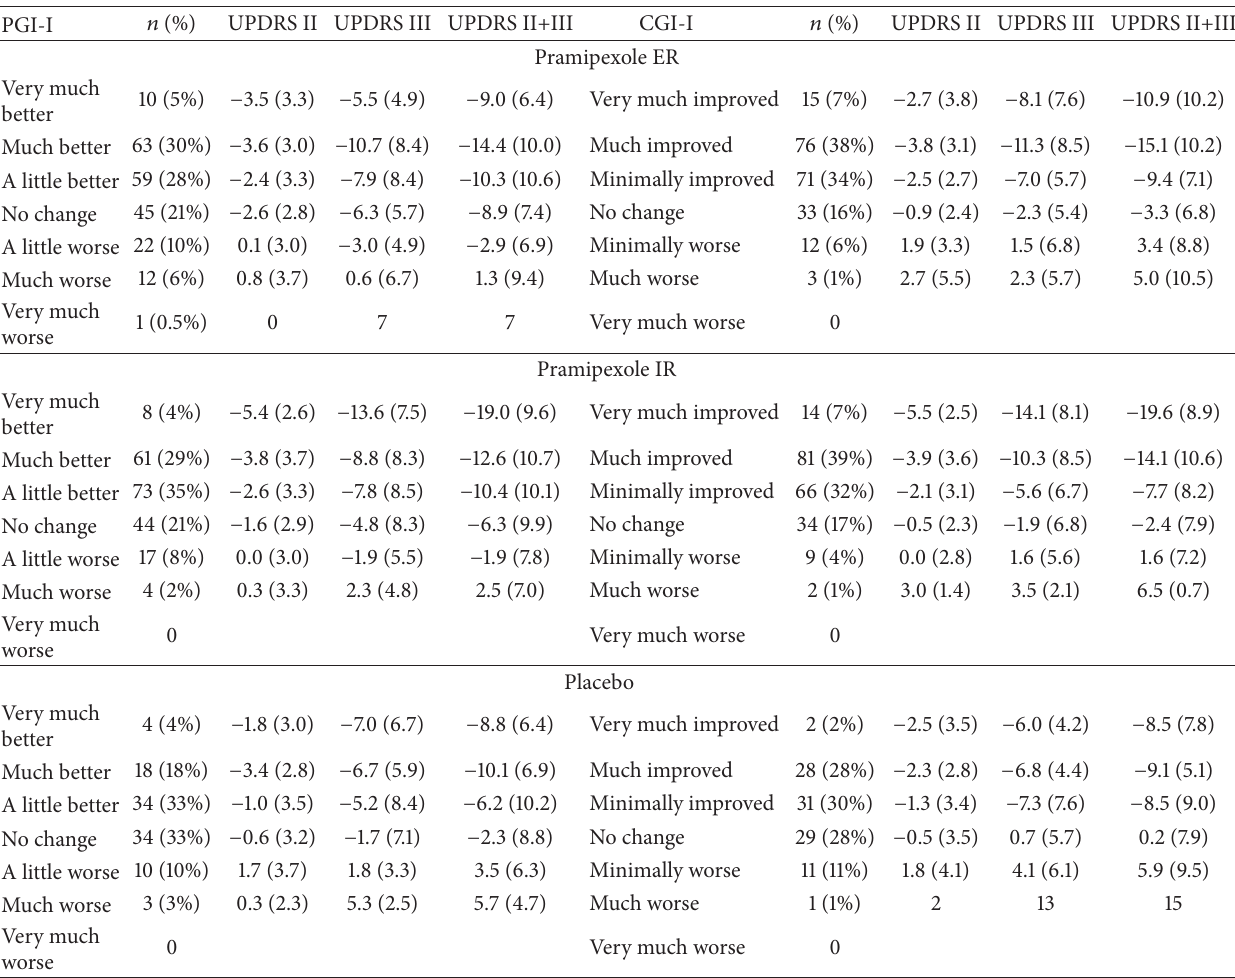
Table 1: Mean changes in UPDRS II, III, and II+III scores according to PGI-I and CGI-I ratings by treatment group in the early PD